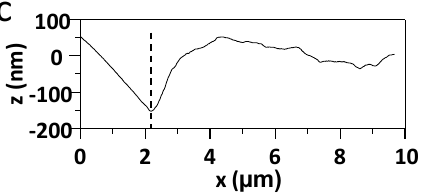
Figure 11. AFM height images of hexagonal-shaped rings in LM w -PLLA-11k spherulite melt-crystallized at T c = 112 °C: ( a ) full image; ( b ) zoomed-in image; and ( c ) height profile.